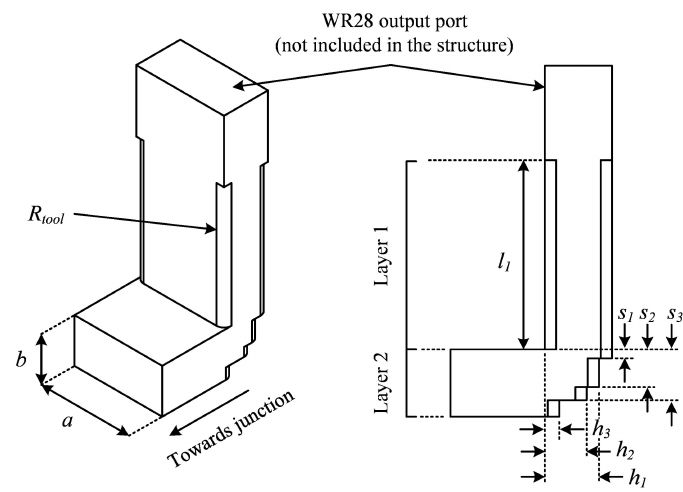
Figure 4. E-plane bend with design parameters definition. Sections to be mechanized in each layer are also indicated.